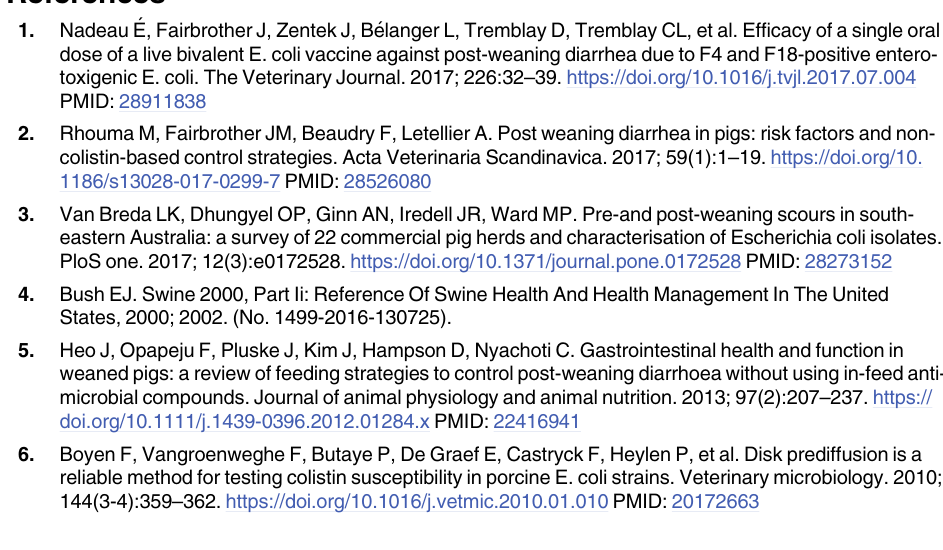
S2 Table. Phylum relative distribution. Relative abundances of phyla in the piglet gut micro- biota per treatment (diet group) and timepoint. S3 Table. Relative distribution of taxa. Relative abundances of taxonomic levels (class, order, family, genus) in the piglet gut microbiota per treatment (diet group) and timepoint. S4 Table. OTU significant differences. OTUs significantly different between treatments before and after